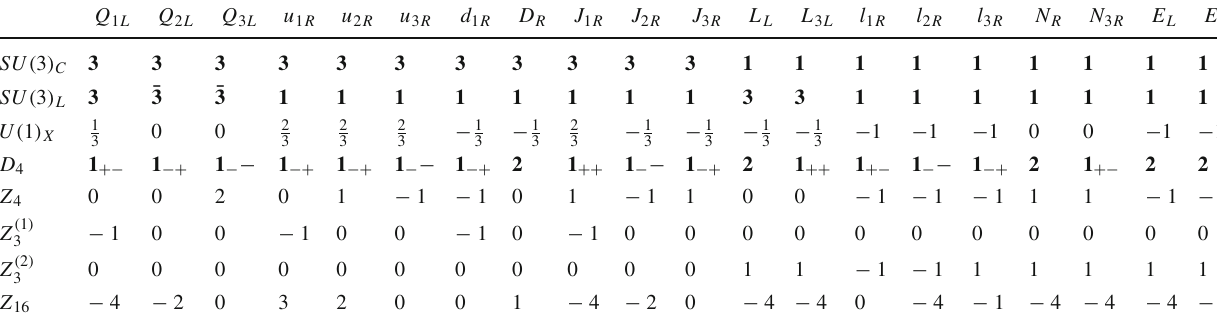
Table 2 Fermion transformations under the SU ( 3 ) C × SU ( 3 ) L × U ( 1 ) X × D 4 × Z 4 × Z ( 1 )